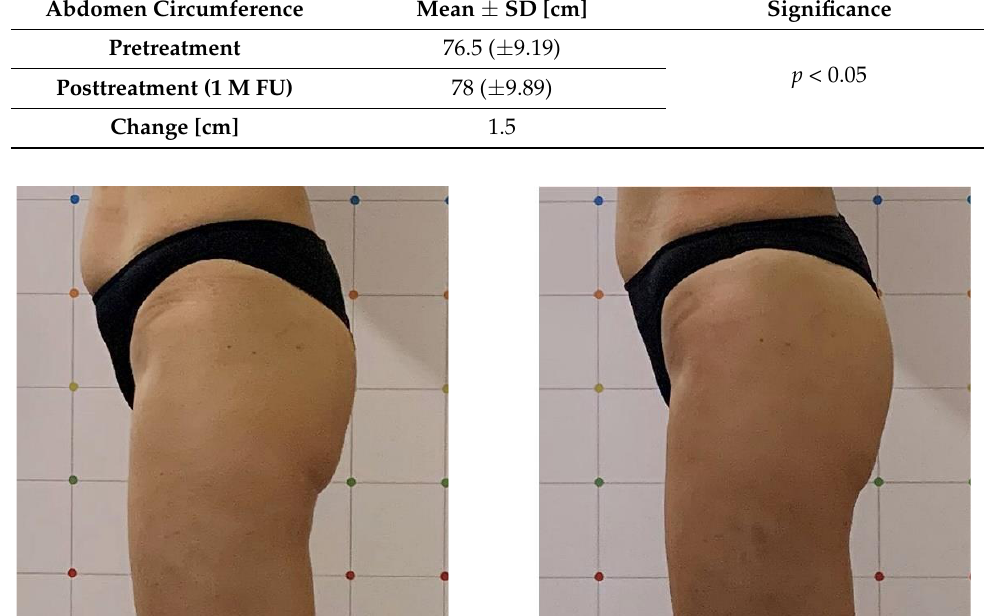
Figure 1. Left lateral view of a female patient before and 1 month after treatment. A good aesthetic improvement in buttocks muscle tone can be observed in the treated area.